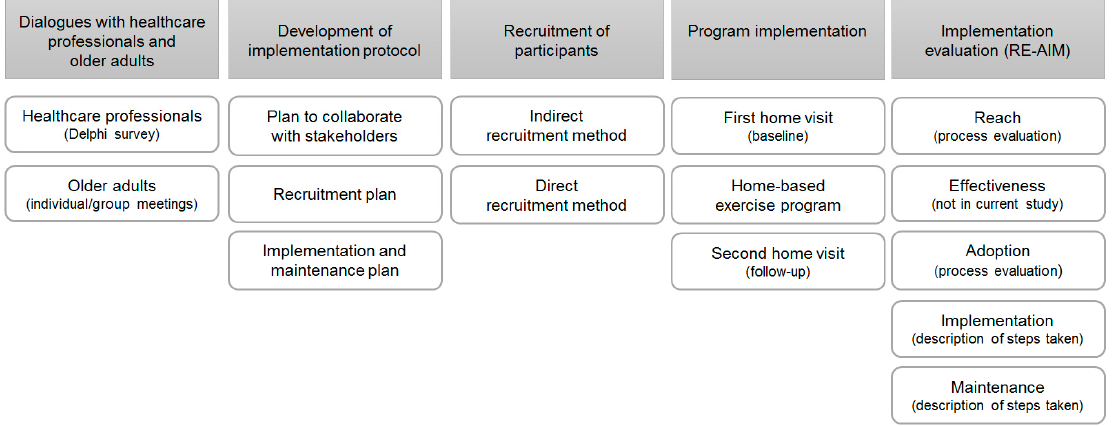
Figure 1. Steps taken to implement a home-based exercise program.